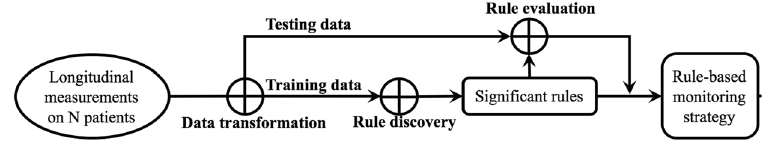
Figure 1. The rule-based analytic framework for longitudinal pattern discovery and adaptive